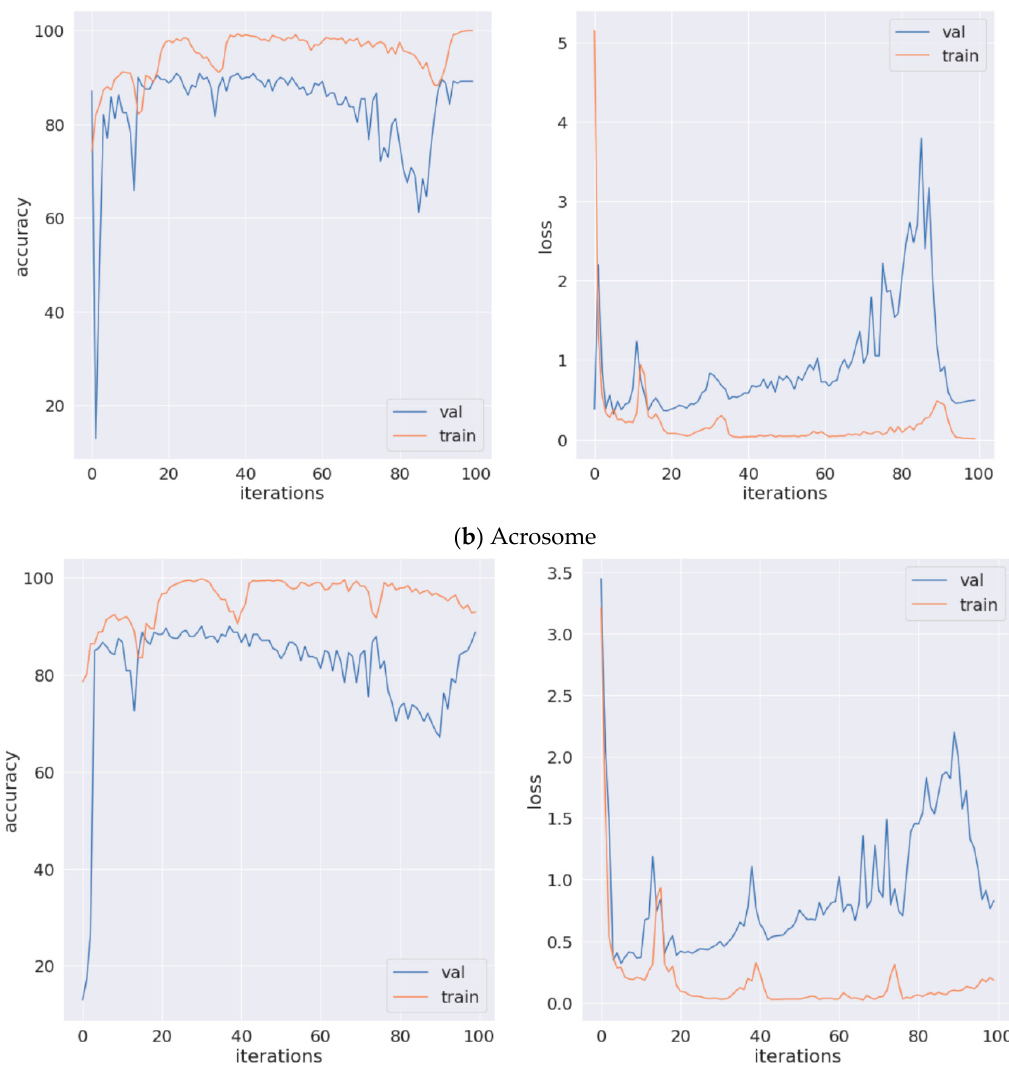
Figure 5. Progression of accuracy and loss on the validation set during sequential deep-learning model training. In this graph, the orange line represents the highest validation accuracy achieved, and the blue line represents the highest training accuracy achieved in the ( a ) vacuole, ( b ) acrosome, and ( c ) head. Similarly, the right side of the graph shows maximum validation loss with the blue line and maximum training loss with the orange line.